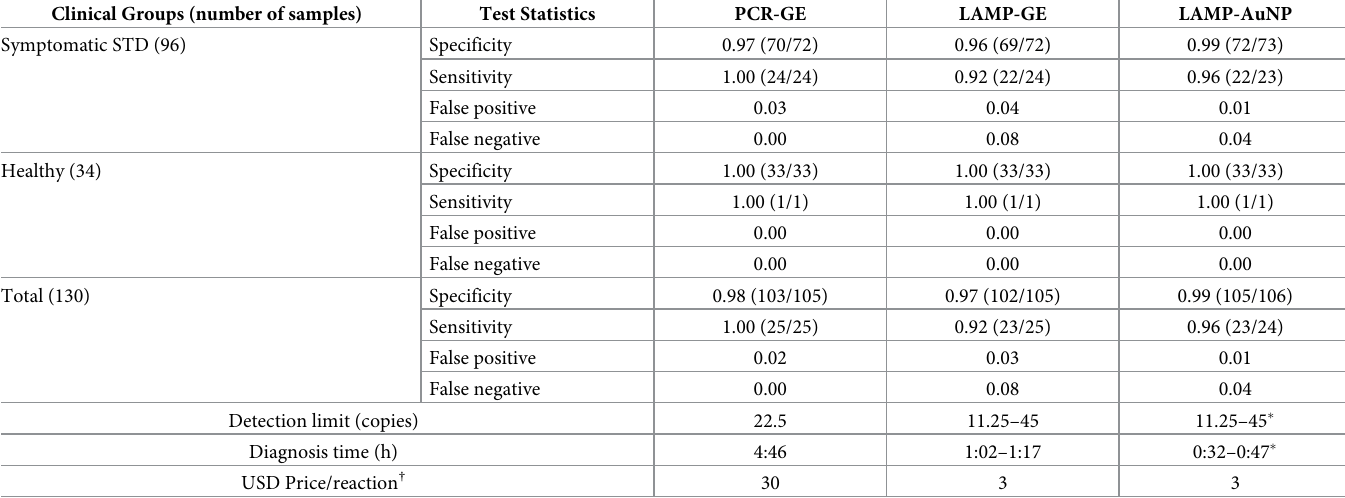
Table 2. Clinical sample evaluation of crude DNA lysis combined LAMP-GE and LAMP-AuNP, compared with a commercial DNA extraction kit and PCR-GE. For specificity, the values in parentheses represent the number of true negatives divided by the number of true negatives and false positives. For sensitivity, the values in parentheses represent the number of true positives divided by the number of true positives and false negatives. Clinical Groups (number of